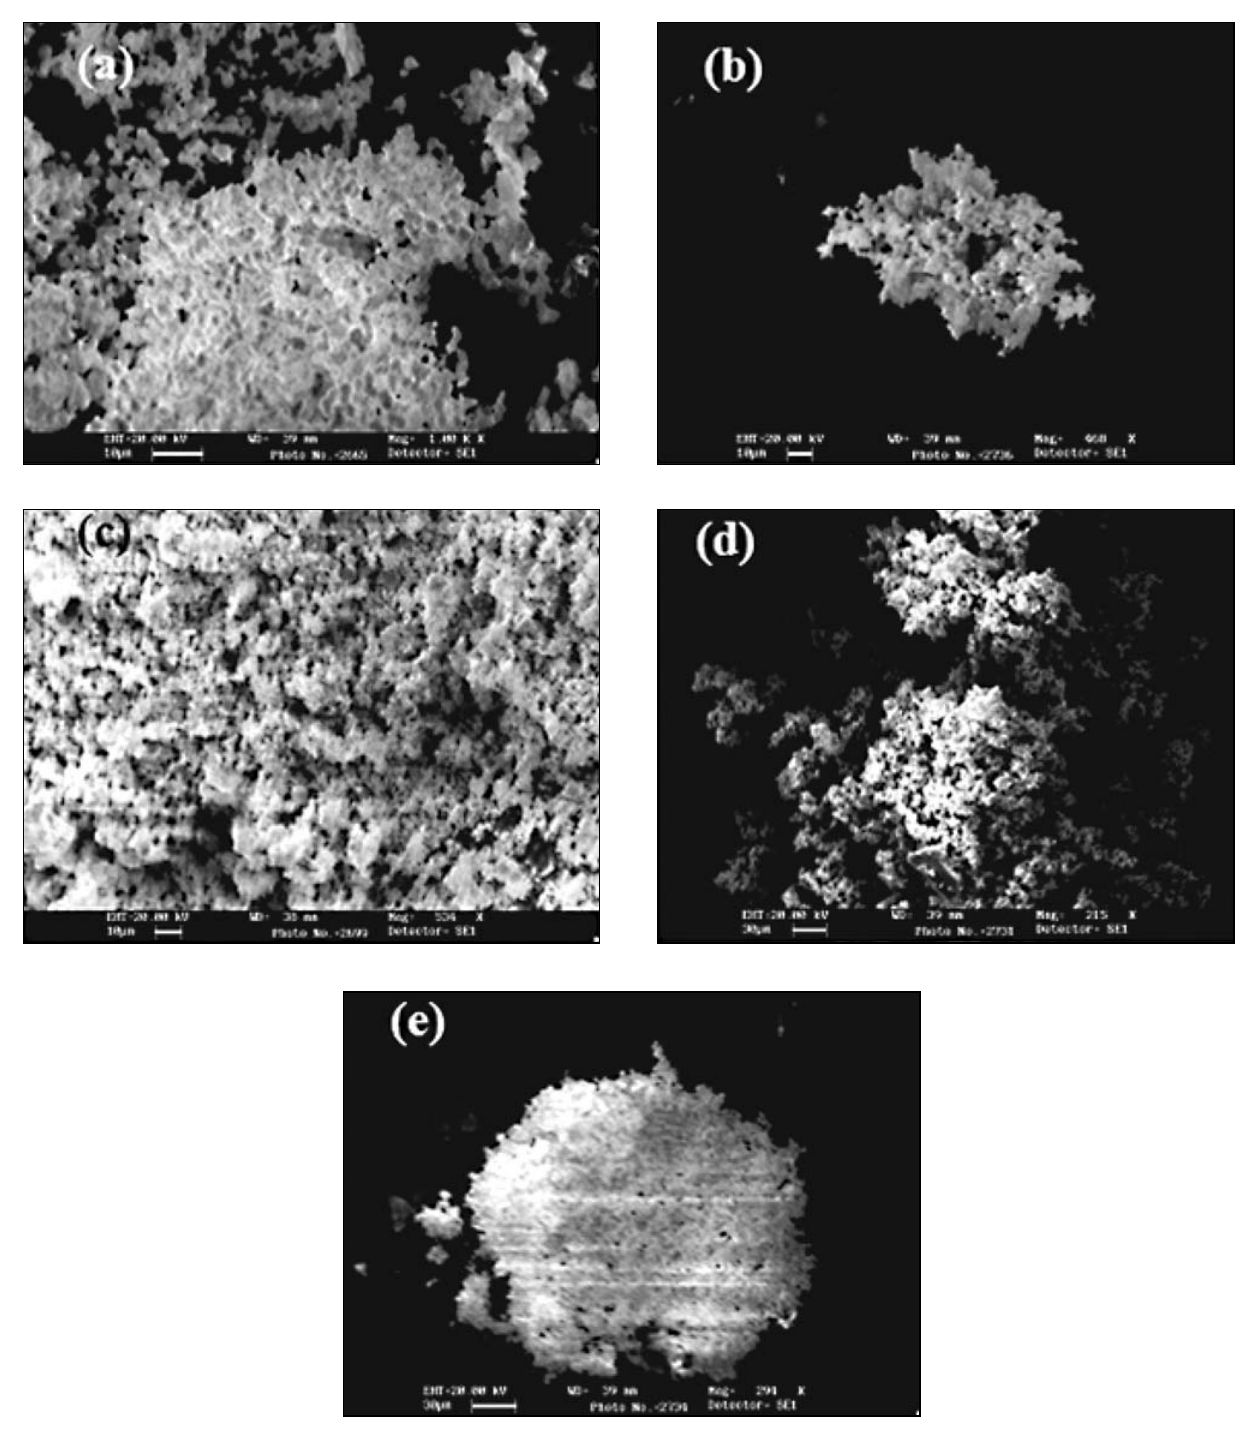
Figure 2. SEM images for (a) undoped CdS (b) CdS:Cu 2+ (c) CdS:Cu 2+ Gd 3+ (d) CdS:Cu 2+ Er 3+ (e) CdS:Cu 2+ Tb